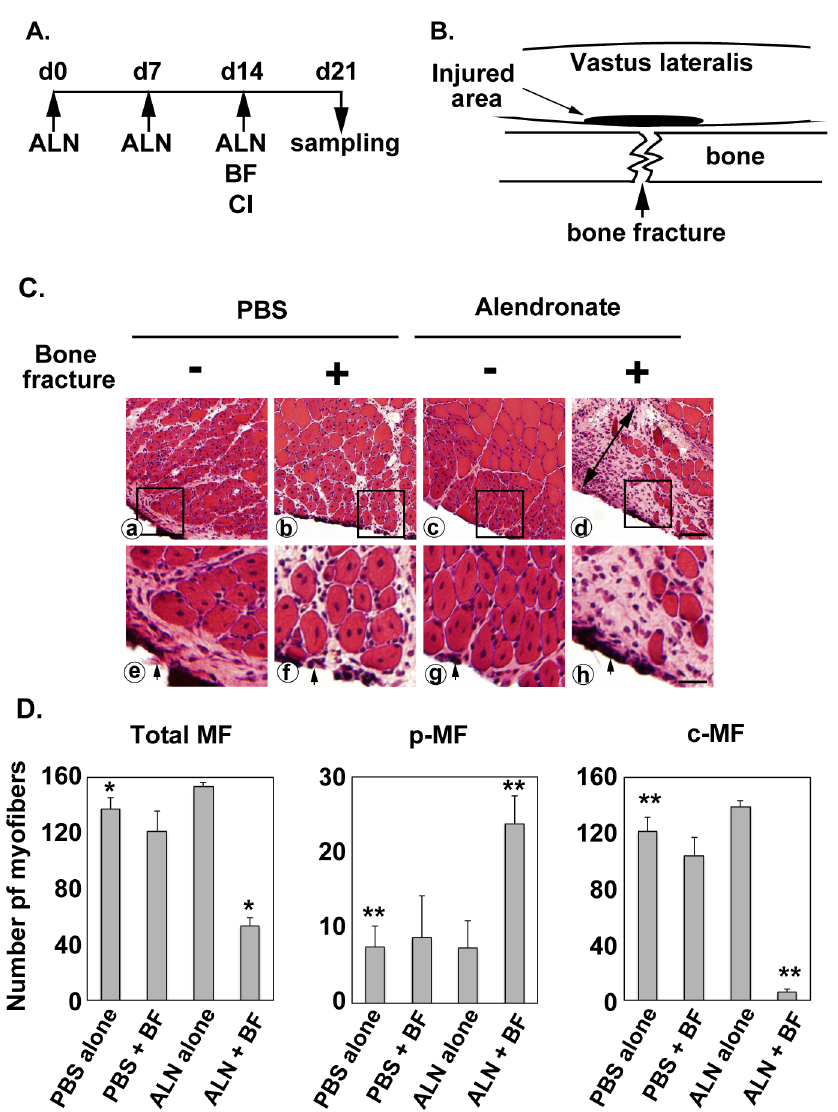
Fig 2. Combination of bone fracture and alendronate treatment prevents muscle regeneration. (A) Experimental schedules.Alendronate or PBS was subcutaneously injected at seven-dayintervals. The femur was brokenand the vastus lateralis muscle was injured by cold shock on day 14, and then the vastus lateralis muscle was removedon day 21. ALN, alendronate; BF, bone fracture; CI, cold injury. (B) Schematic view of the fracture site of femur and injuredarea of the vastus lateralis. (C) Histopathology of muscle regeneration of vastus lateralis after combination of bone fracture and muscle cold injury. A double-headedarrow in (d) represents the scar. Arrows in (e-h) represent the surface injuredby cold. Squares in the top panels(a-d) indicatethe areas magnifiedin the bottom panels (d-f). Scale bars, 60 μ m in (a-c), 20 μ m in (e-h). Numbers of peripherally nucleatedmyofibers (p-MF) and centrally nucleatedmyofibers (c-MF) were countedin the regenerating area (1.0 x 0.2 mm) of three independentsamples. “Total” means the sum of the two types of myofibers. The averageand standarddeviationwere estimated. Statistical significance(P-value)of difference betweenmuscles of PBS-injected mice without bone fracture and each experimental group was analyzed using ANOVA. * , p < 0.05; ** , p <